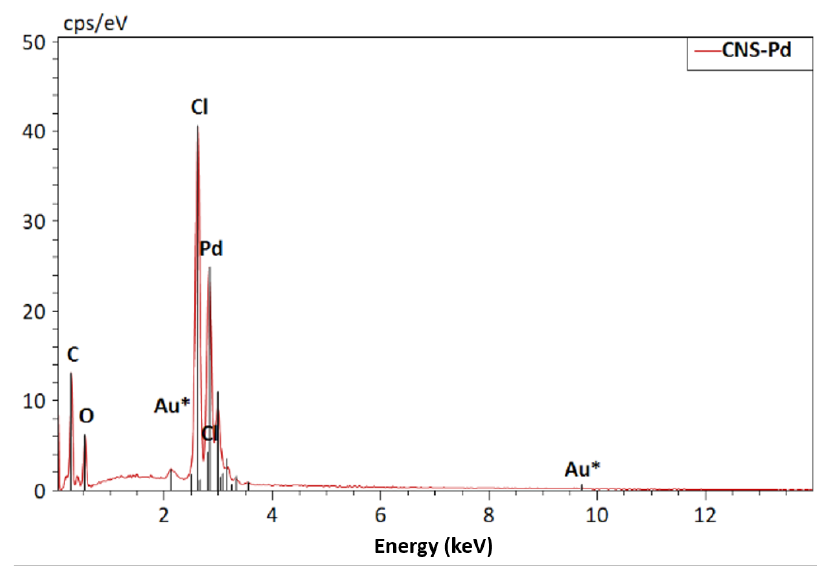
Figure 2. EDS absorption spectrum of CNS-Pd.